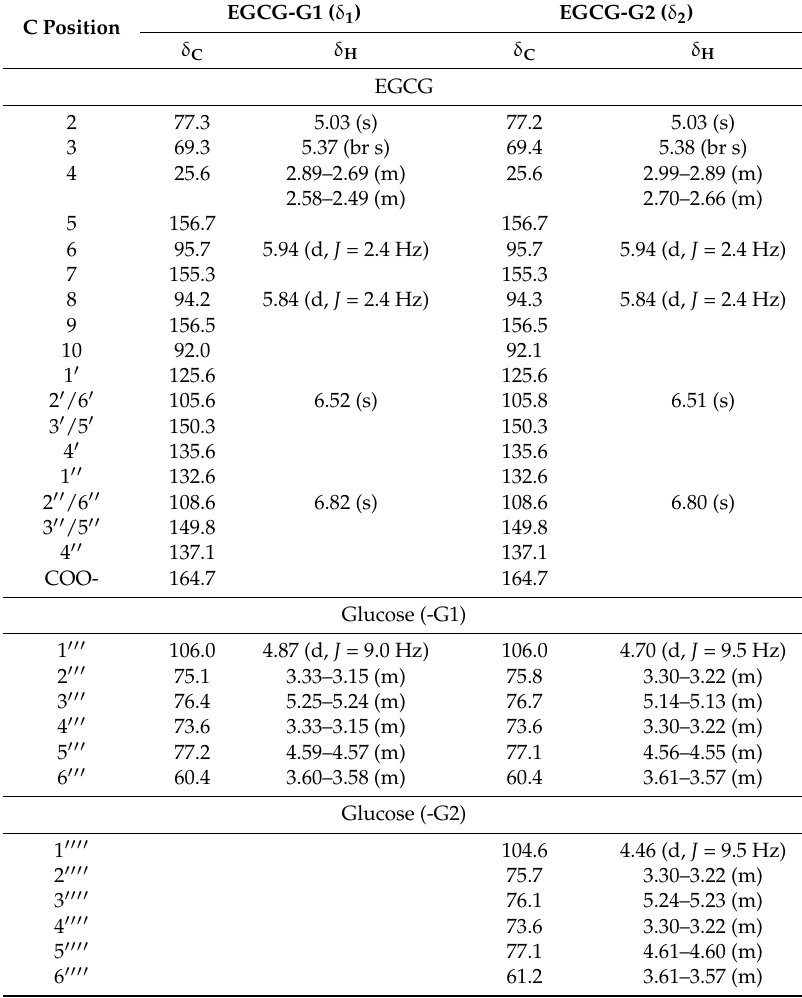
Table 1. 1 H-NMR and 13 C-NMR data of EGCG-G1 and EGCG-G2 in DMSO- d 6 a